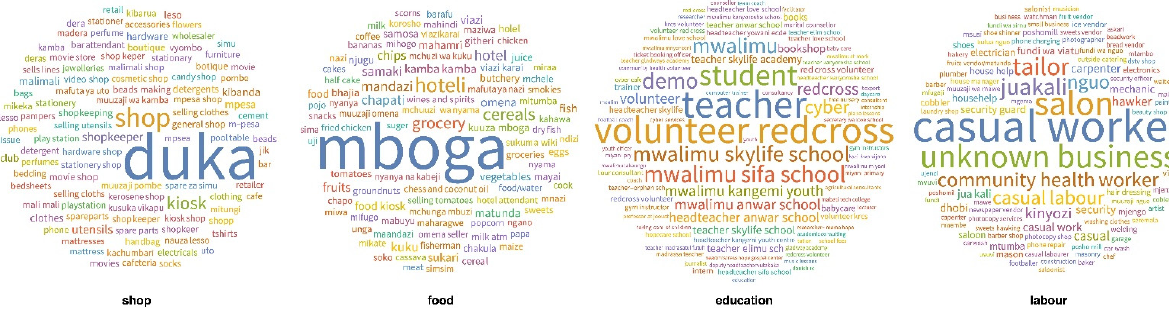
Figure 8. Breakdown of Four Business Types into Vendor or Wage Earner Descriptions Chosen by Members. Word cloud is weighted by membership numbers in each sector.